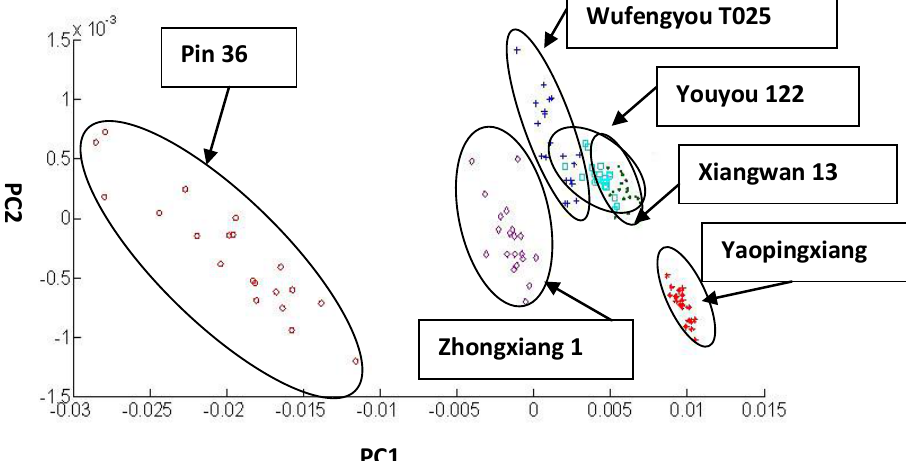
Figure 7. Classification of the six rough rice varieties using PC1 and PC2.